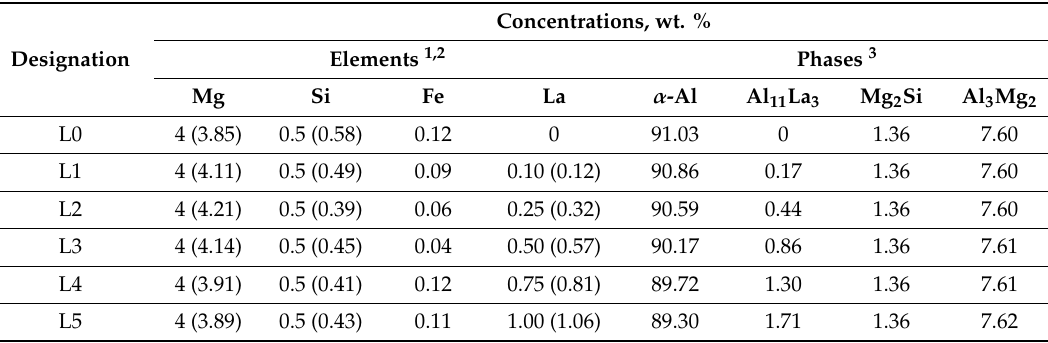
Table 1. Chemical and phase composition (at 20 ◦ C) of the experimental